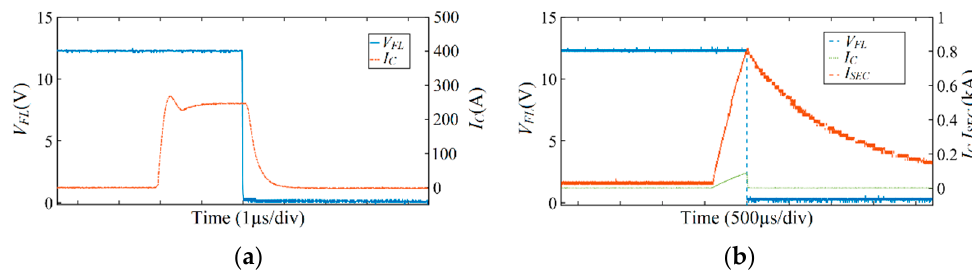
Figure 15. ( a ) Short-circuit (SC) type I waveform; ( b ) Short-circuit (SC) type II waveform.